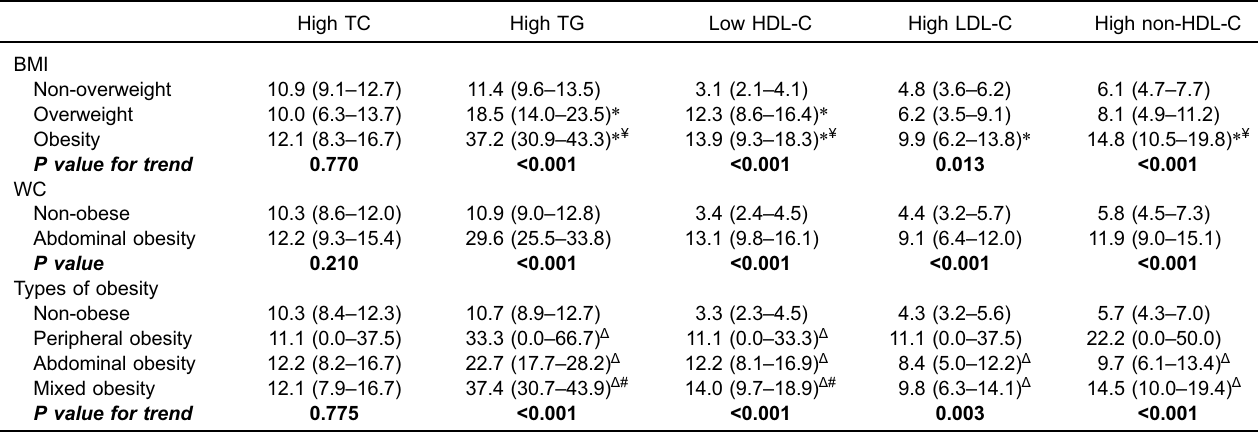
Table 5. Prevalence of abnormal levels of serum lipids among children and adolescents by obesity extent and type High TC High TG Low HDL-C High LDL-C High